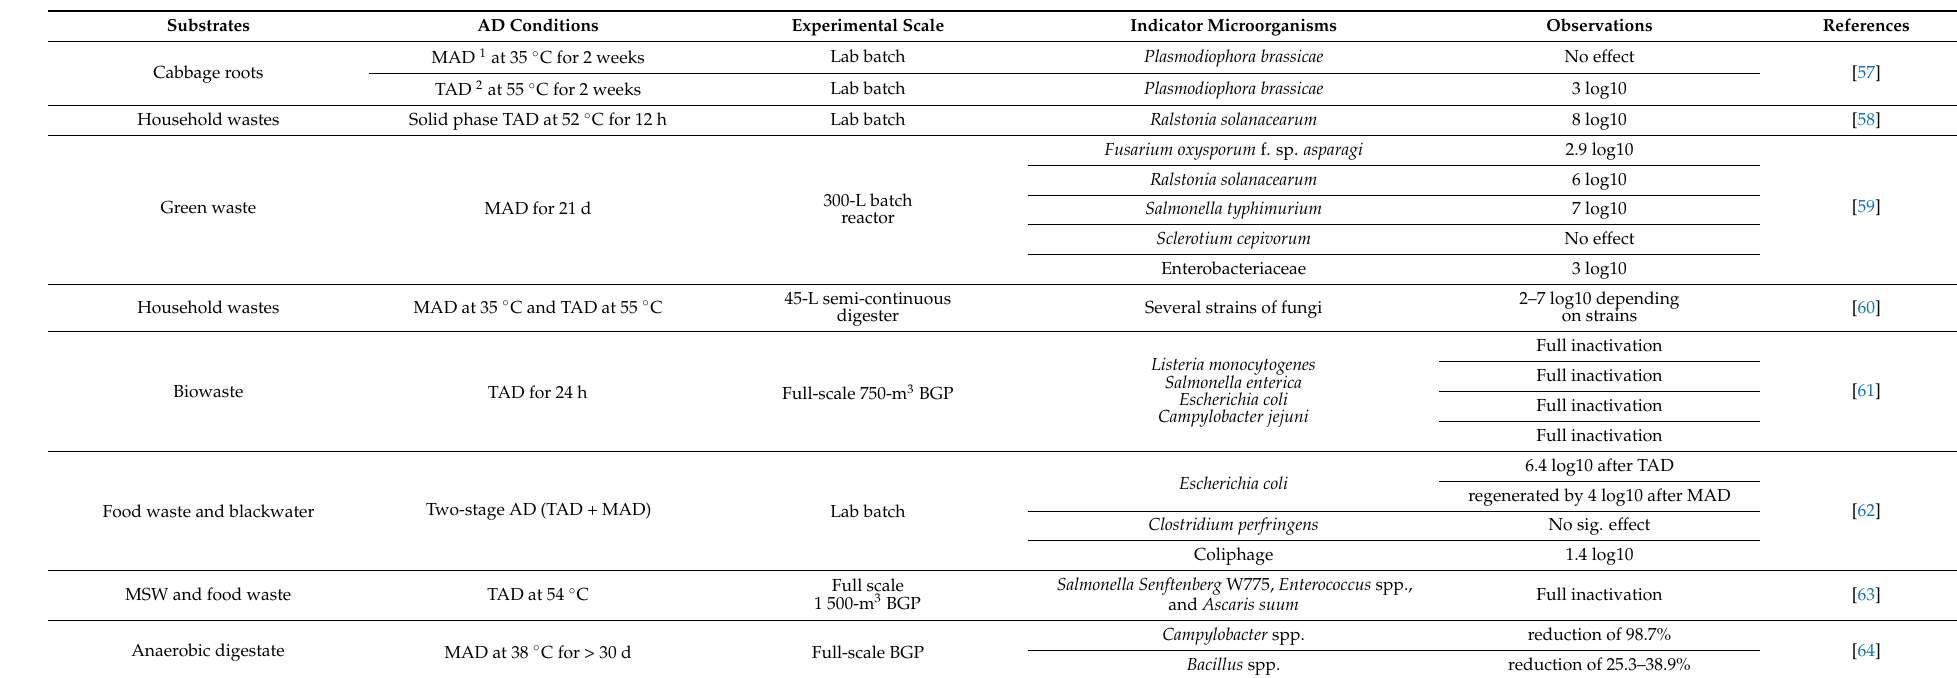
Table 5. Literature data about the efficiency of AD process on pathogens inactivation in other